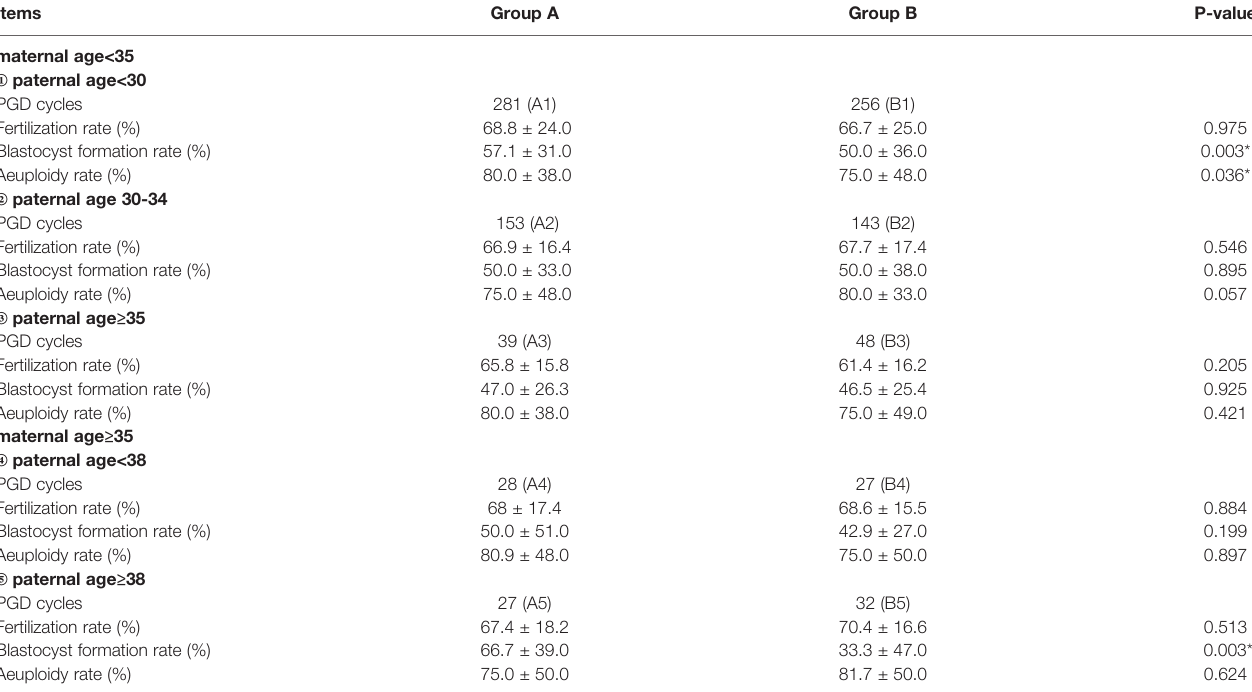
TABLE 3 | Comparison of blastocyst conditions between male and female carriers in different age groups. Items